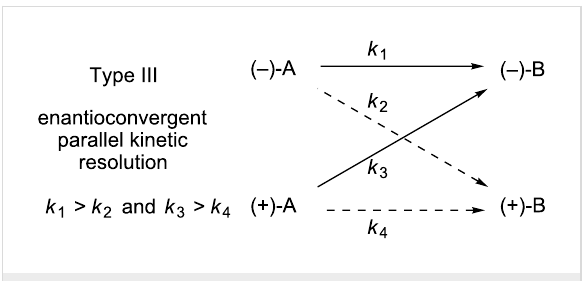
Figure 4: Enantioconvergent parallel kinetic